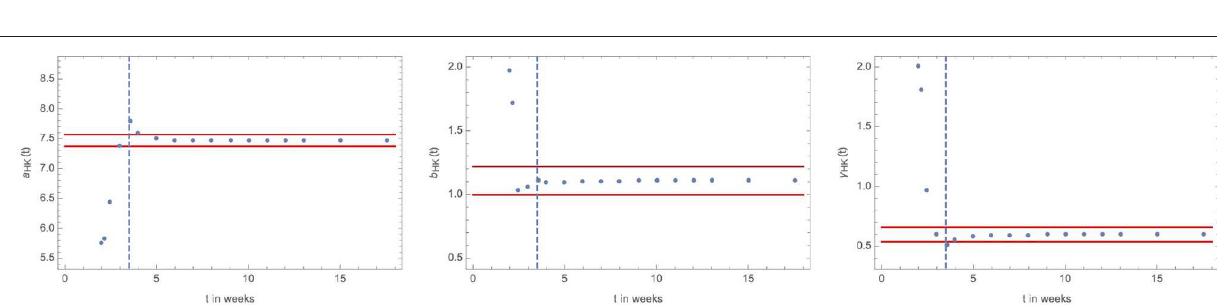
the HK SARS-2003 case, the main features remain